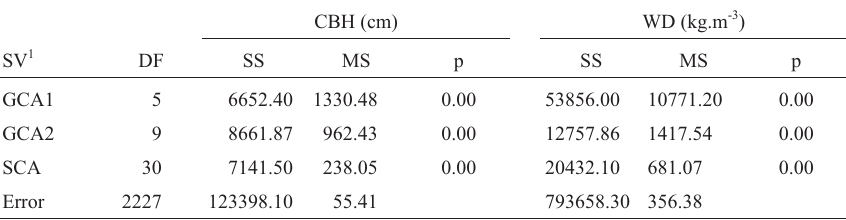
Table 4 - Summary of the analyses of variance of the half-diallel, considering the mean of the three places for circumference at breast height (CBH) and wood density (WD) obtained in the evaluation of two-year-old trees from crossings of Eucalyptus globulus with elite